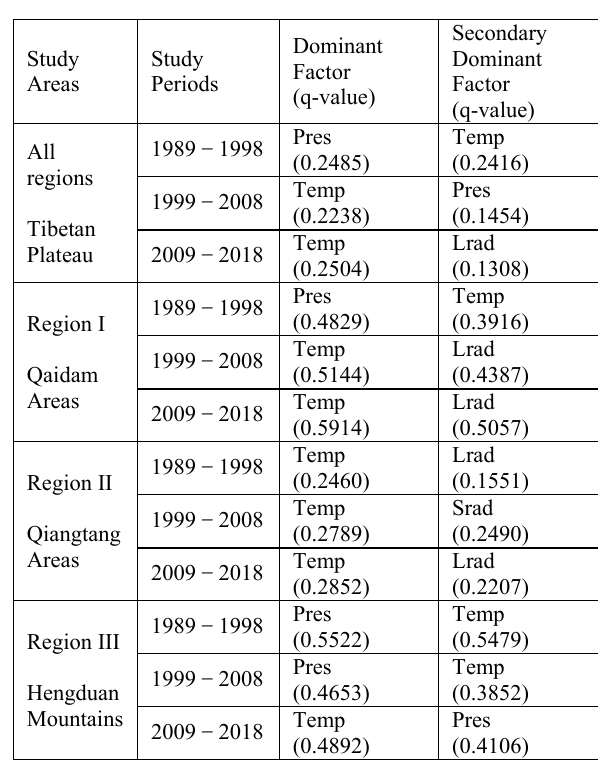
Table 1 . The dominant climatic factors of snow cover